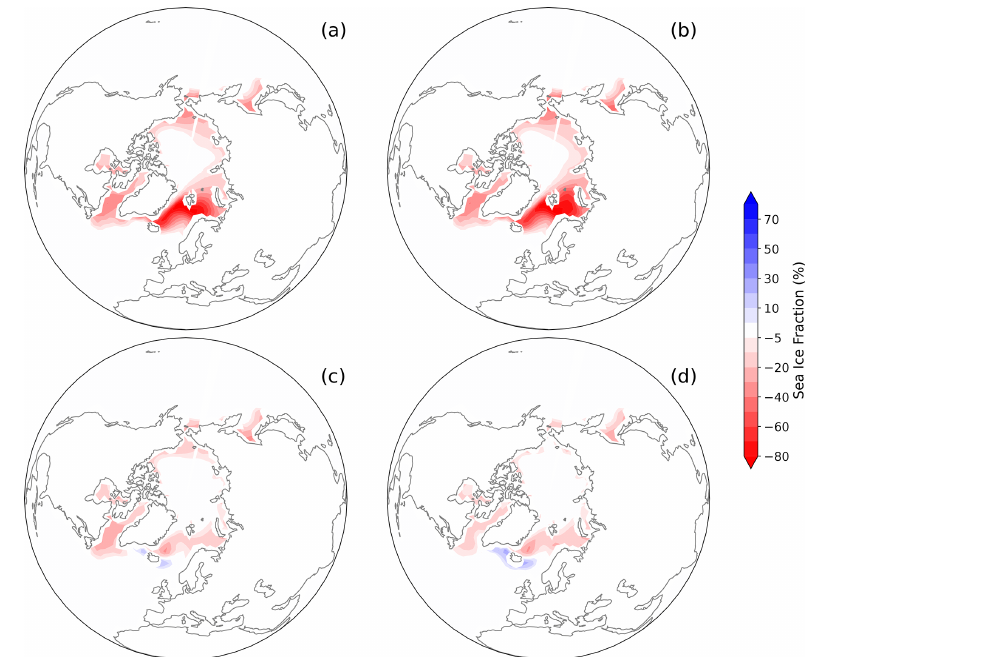
Figure B3. Sea ice fraction difference (%) between future scenario (2041–2070) (a) RCP8.5, (b) WAIS3m, (c) GrIS1m, (d) GrIS3m and historical simulation (1976–2005) for the Northern Hemisphere in NDJFM.